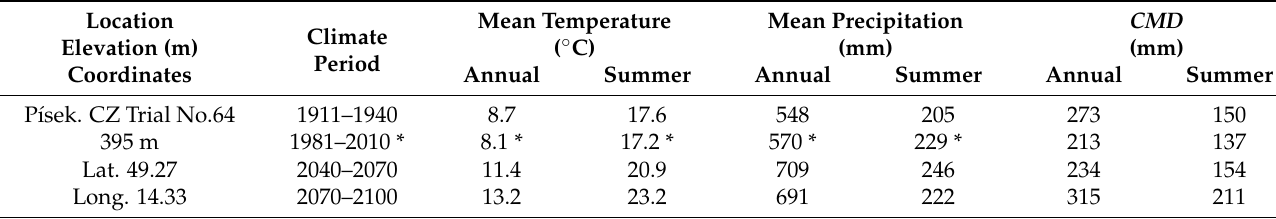
Table A2. Past, “current” and projected future climate data for the three trial sites in the Czech Republic (source of climate data: ClimateEU ; projected pathway